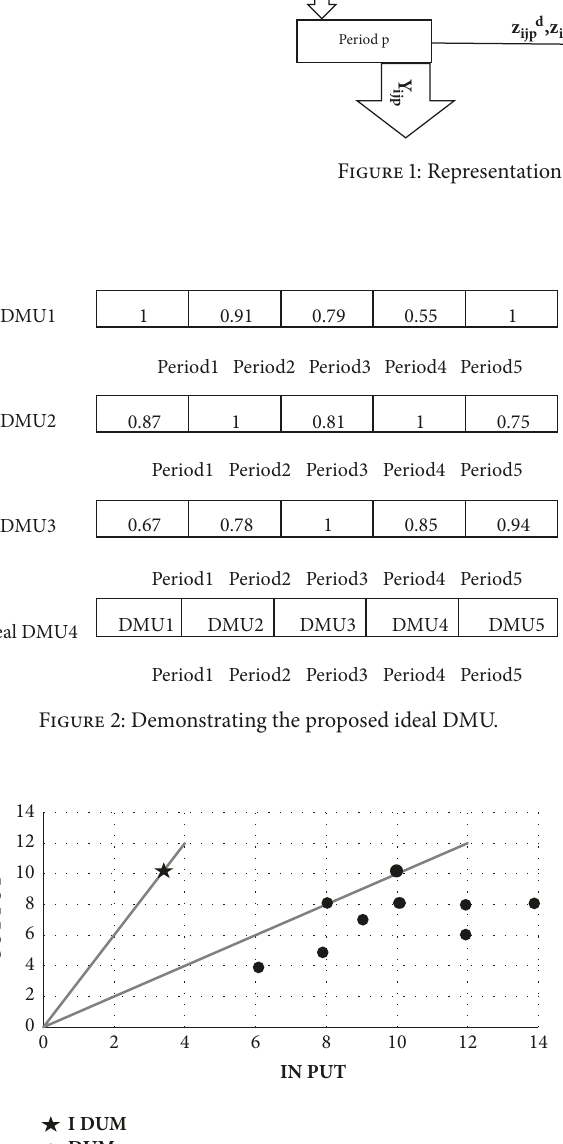
benchmarks themselves. The proposed ideal DMU, shown